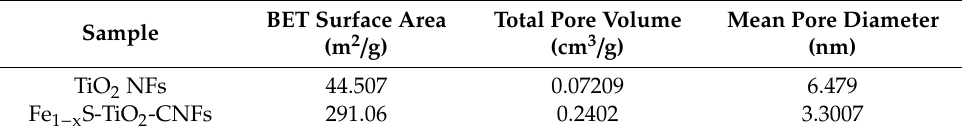
Figure 5. Nitrogen adsorption and desorption isotherm ( A ) and pore size distribution graph ( B ) for the Fe 1 − x S-TiO 2 / CNFs composite as compared to TiO 2 NFs. Table 1. Surface area, pore volume, and pore diameter of the Fe 1 − x S-TiO 2 / CNFs composite as compared to the TiO 2